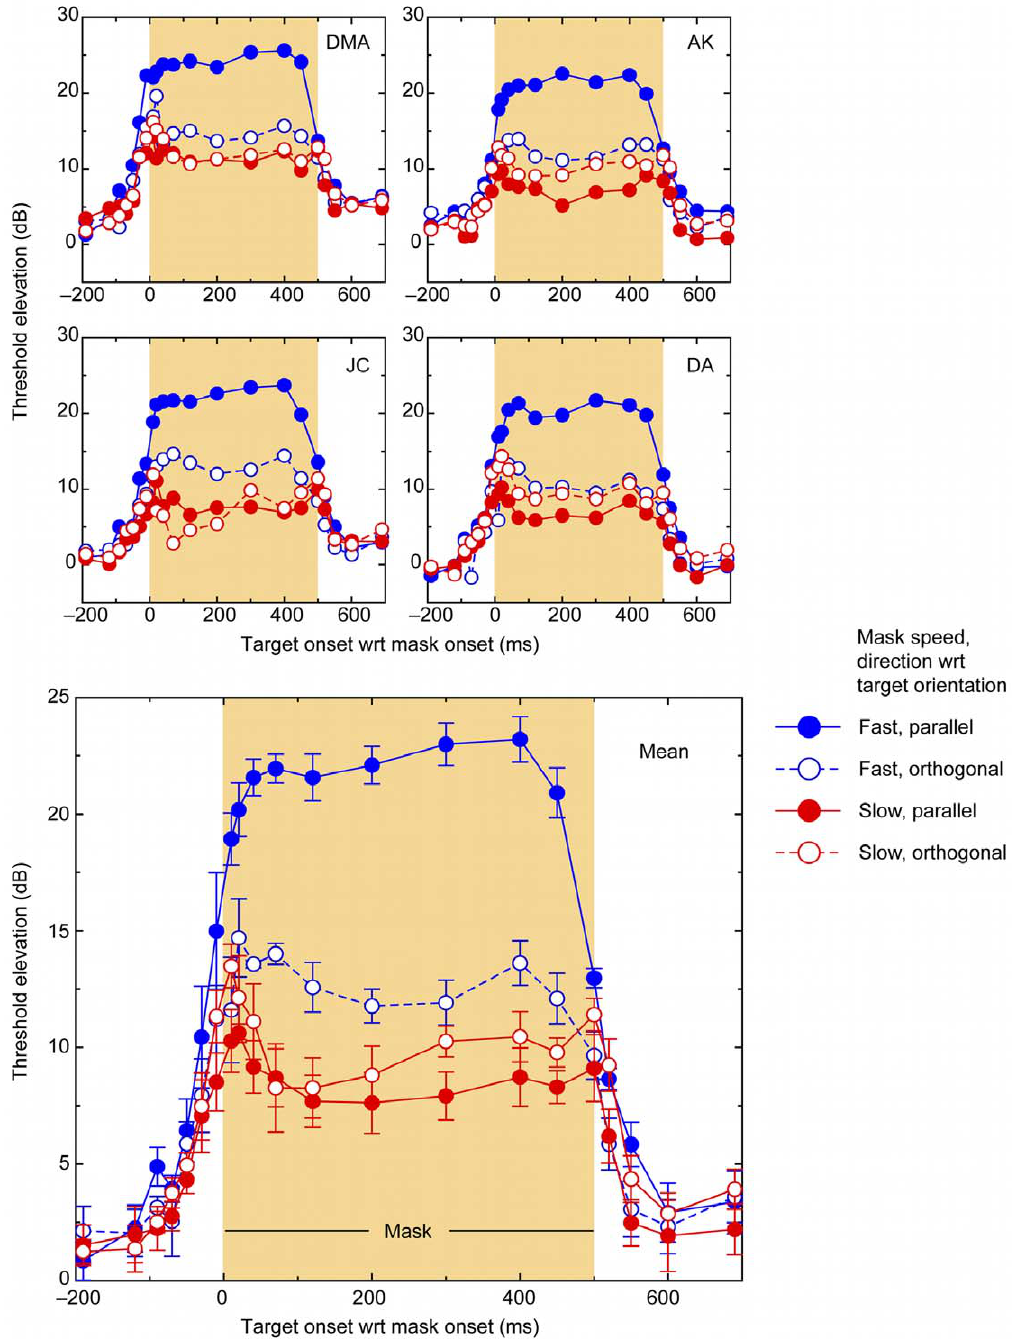
Figure 2. Masking elevations of a brief target grating from unmasked baseline as a function of presentation time relative to the onset (0 ms) of a 500 ms motion mask. The plot shows the means of four observers, plotted with + 1 standard error bars. To capture any effects of backward and forward masking, target gratings were presented as early as 190 ms before the motion mask began (indicated by negative timing), as well as up to 190 ms after the motion mask ended. Results are shown for fast and slow motion masks, and for target gratings parallel and orthogonal to the motion direction. doi:10.1371/journal.pone.0028675.g002 other, t (3)=1.85, p= 0.16, and the two orthogonal conditions (fast vs. slow) also did not differ, t (3)= 2.11, p =.13. However, fast parallel masking was significantly greater than fast orthogonal, t (3)= 32.99. p v 0.001, and also than slow parallel, t (3) =38.07, Table 1). Pairwise comparisons between the slow motion masking conditions showed these were not significantly different from each p v 0.001.